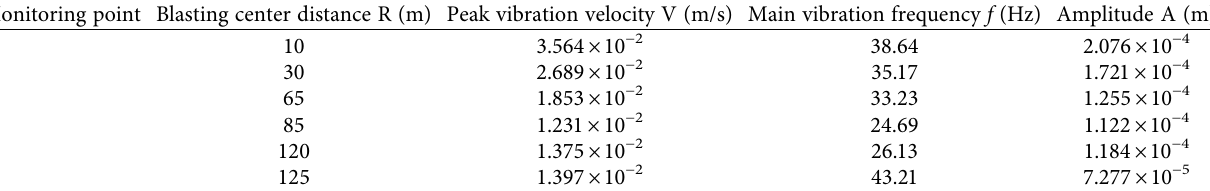
Table 1: Results of blasting vibration monitoring data.